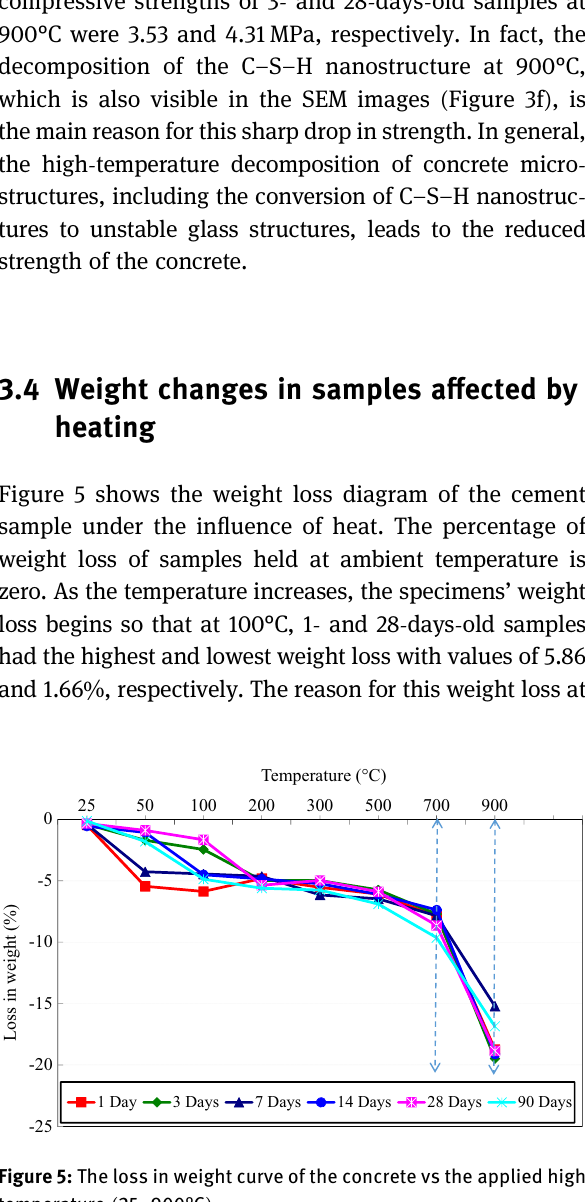
Figure 5: The loss in weight curve of the concrete vs the applied high temperature ( 25 – 900°C )